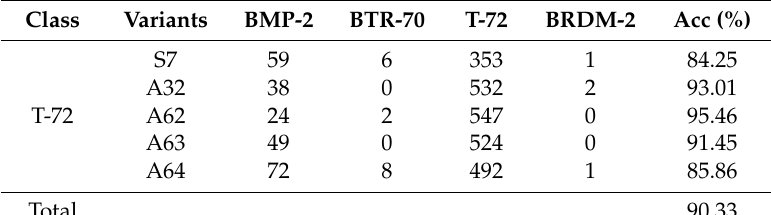
Table 9. Recognition accuracy comparison under EOC2 (configuration variants).